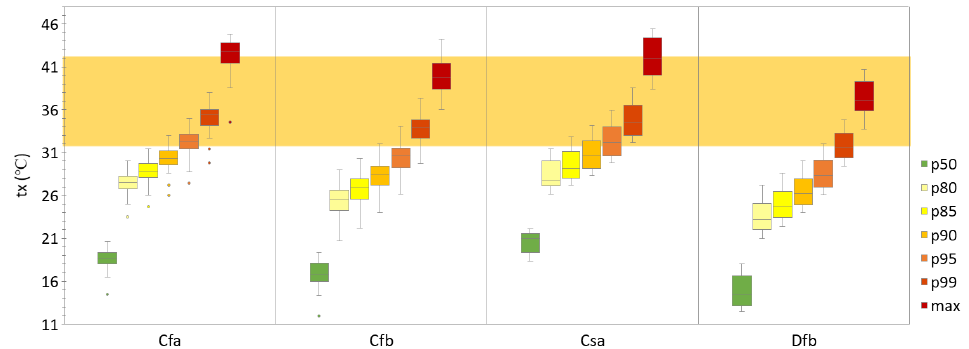
Figure 2. Medians (p50); 80th, 85th, 90th, 95th, and 99th percentiles (p80, p85, p90, p95, and p99) and absolute maxima (max) of daily maximum temperature tx time series for the period 1961–2020 by climate zones; the range of values used in threshold indicators is shown in light